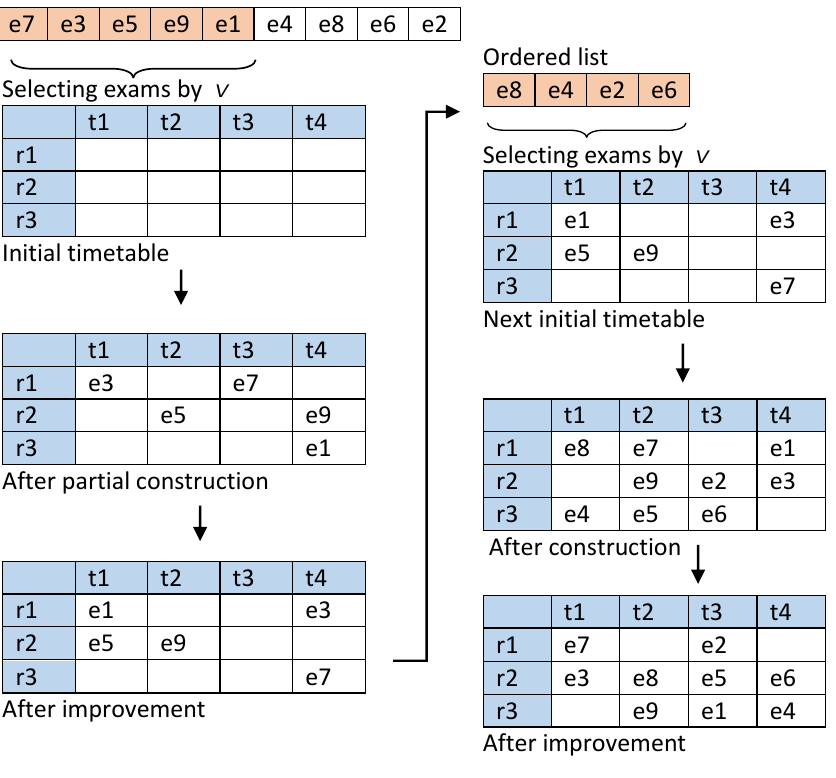
Figure 1. An Illustration of PGH-mGD for examination timetabling